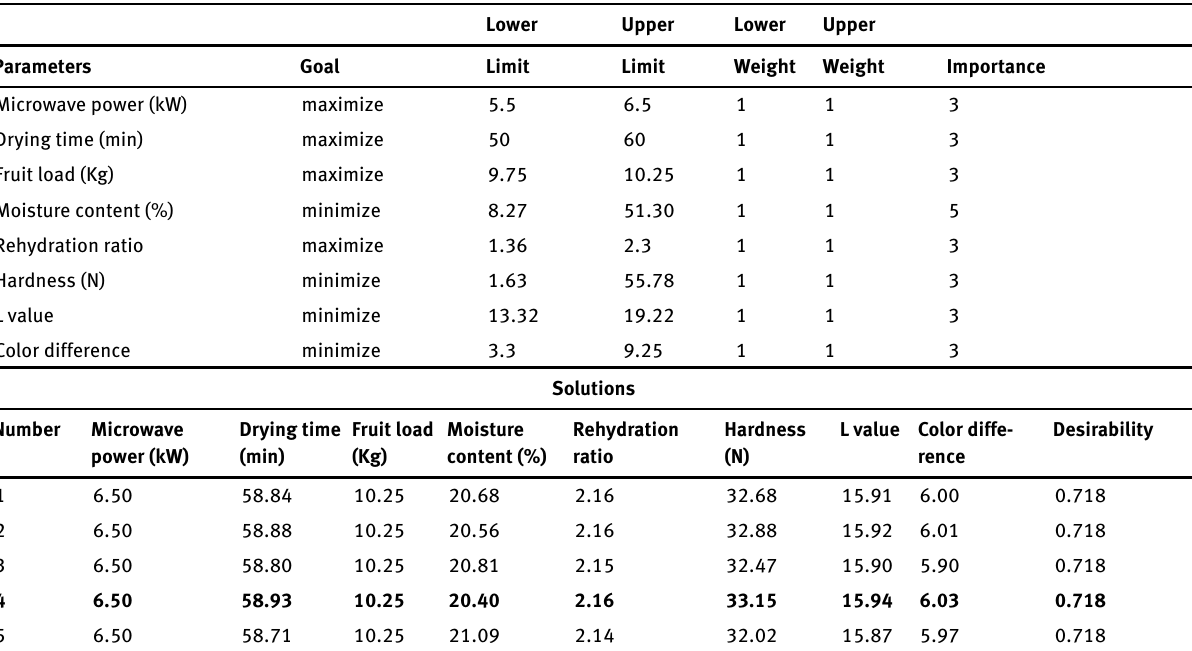
Table 3 Results of numerical optimization using desirability function of microwave-vacuum drying of Saskatoon